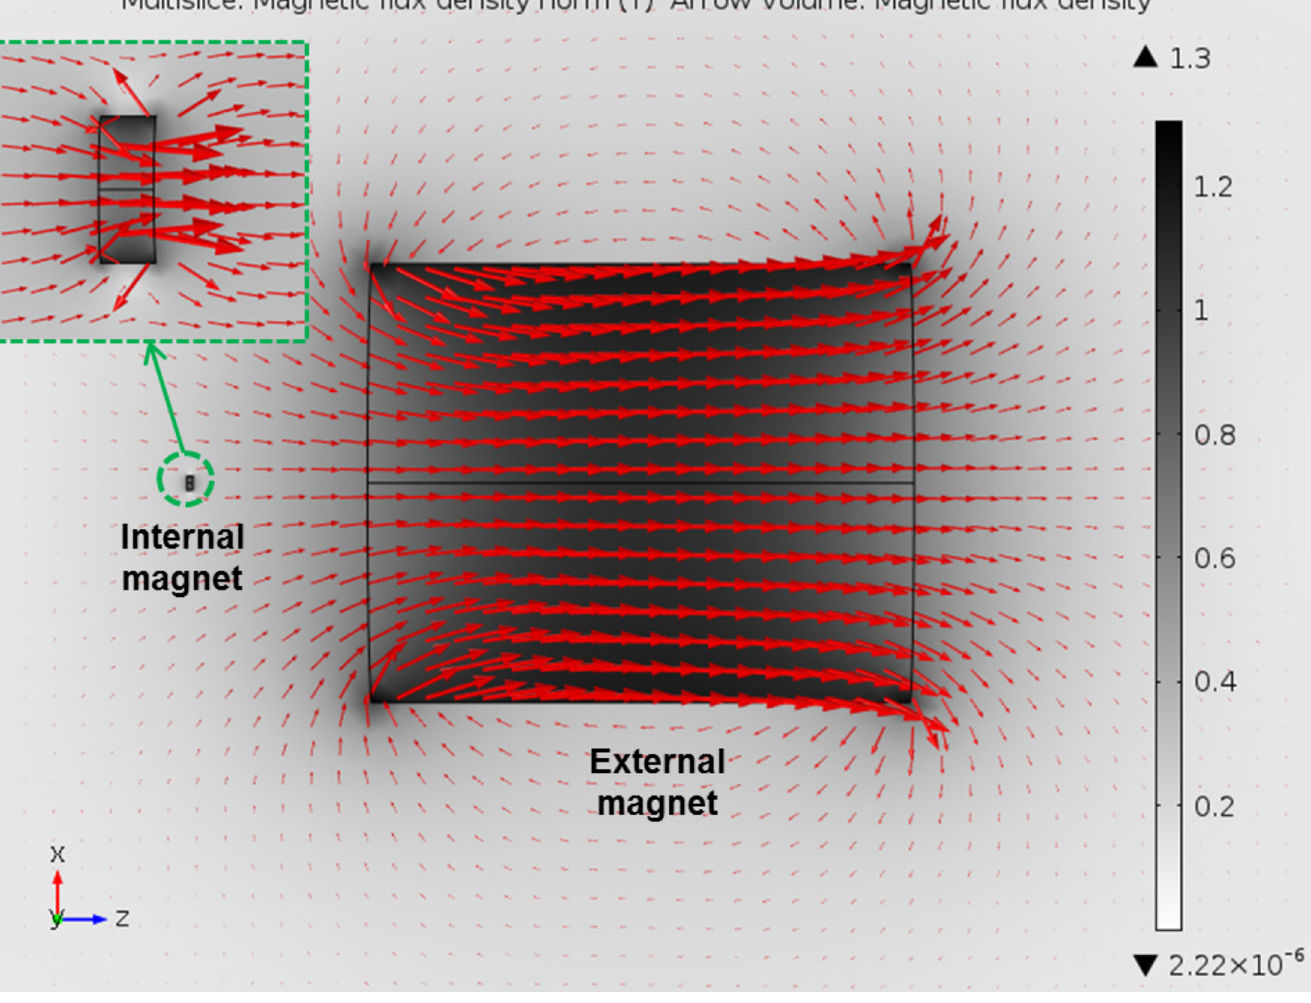
Fig 10. Simulation results for the estimation of external magnet size using COMSOL Multiphysics